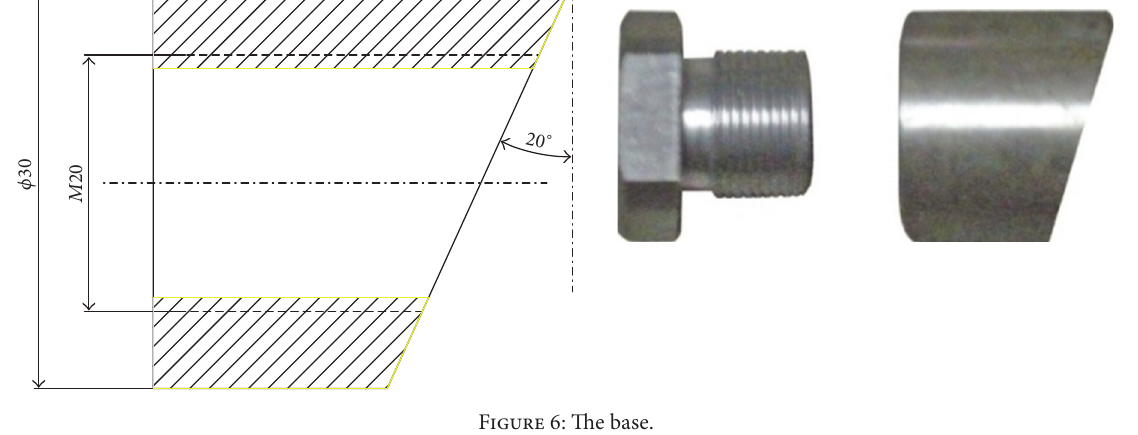
Figure 6: The base.